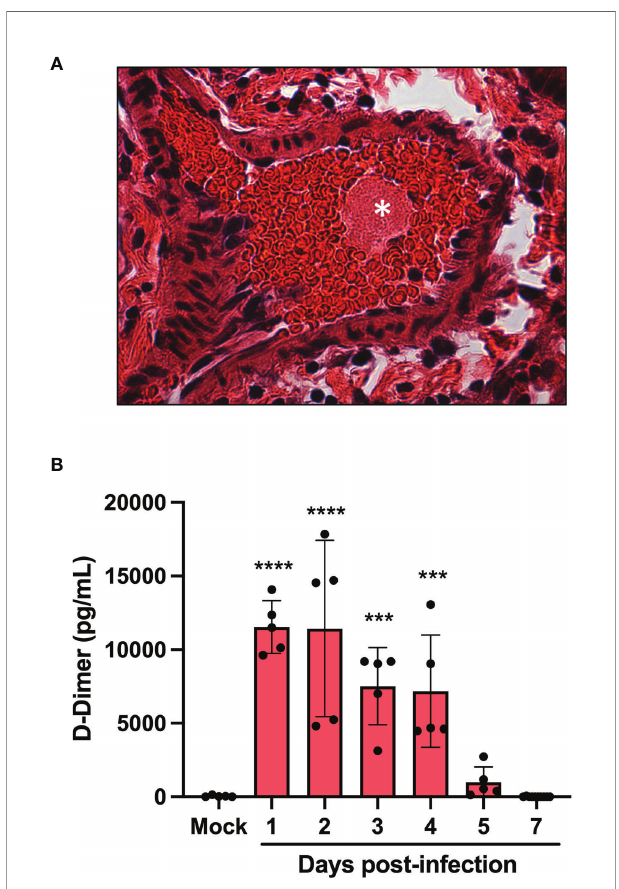
FIGURE 3 | Pulmonary thrombus and D-dimers in plasma of SARS-CoV-2 infected mice. (A) Lung tissue section from day 7 SARS-CoV-2-infected showing blood clots (asterisk). (B) The concentration of D-dimers in plasma of mock and SARS-CoV-2 infected mice were determined at several time